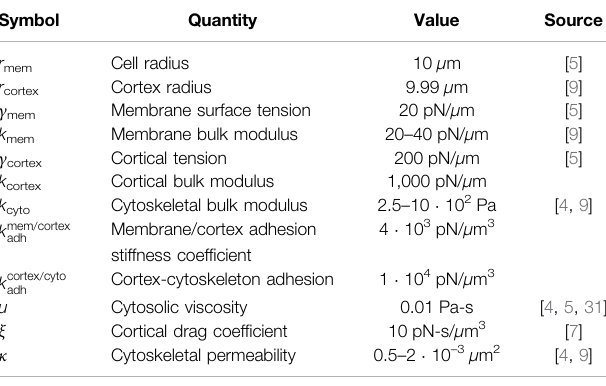
TABLE 1 | Default model parameters for the blebbing model. Values for the shear modulus were taken tobe the same value as thoselisted for the bulk modulus for the membrane, cortex, and cytoskeleton,